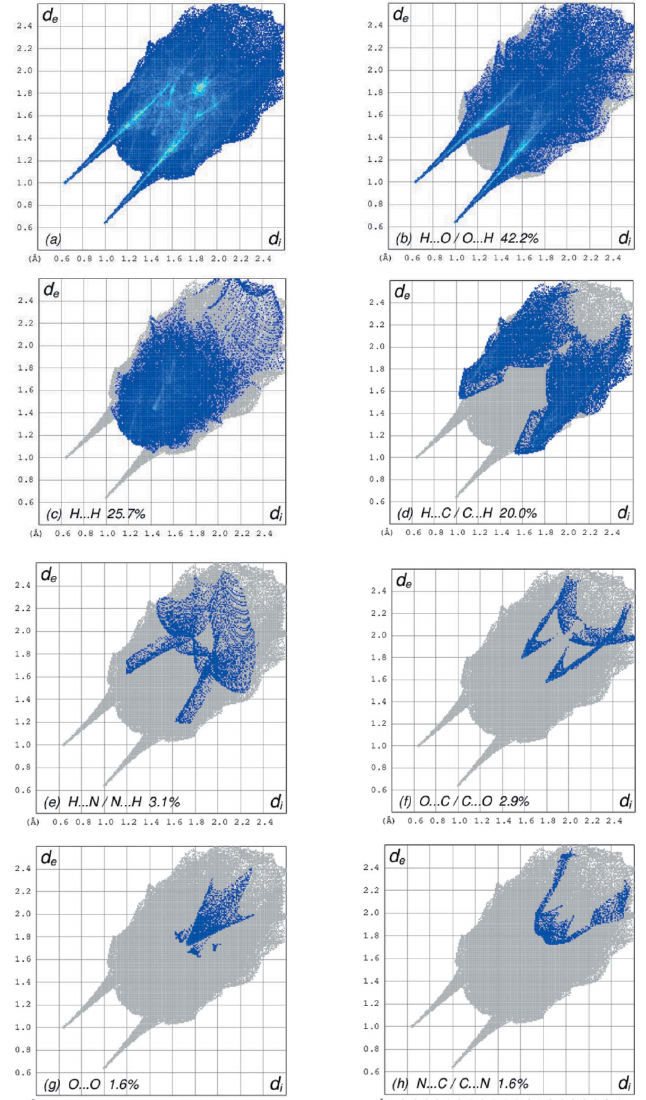
Figure 4 View of the three-dimensional Hirshfeld surface of the title complex plotted over electrostatic potential energy in the range (cid:3) 0.1045 to 0.2914 a.u. using the STO-3G basis set at the Hartree–Fock level of theory. N— H (cid:2)(cid:2)(cid:2) O and O—H (cid:2)(cid:2)(cid:2) O hydrogen-bond donors and acceptors are shown as blue and red regions around the atoms corresponding to positive and negative potentials, respectively.